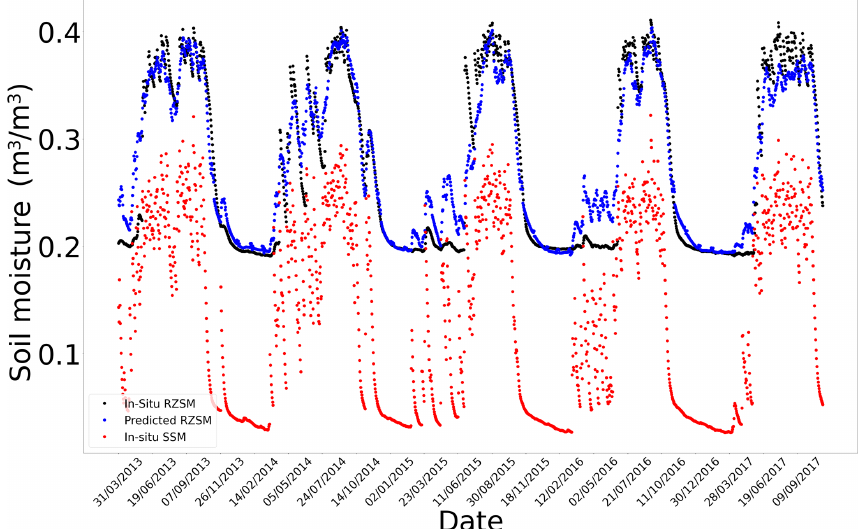
Figure E2. In situ SSM, in situ RZSM, and predicted RZSM series at station Beloufoungou Mid (AMMA-CATCH) with model